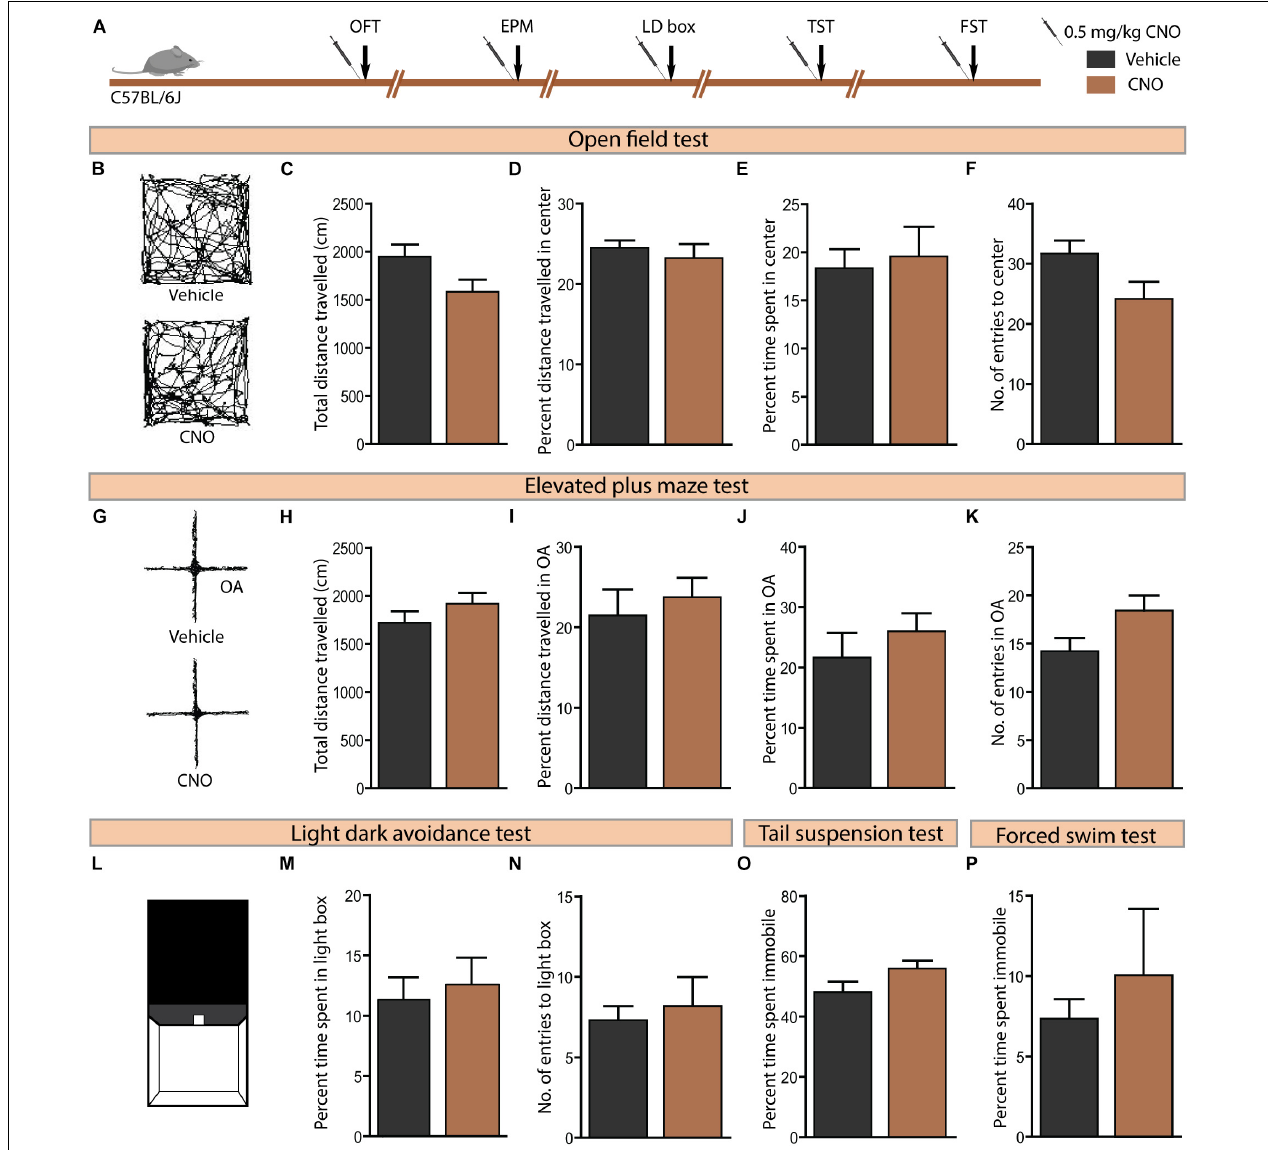
FIGURE 6 | Acute CNO administration in C57BL/6J mice does not influence anxiety or despair-like behaviour. (A) Shown is a schematic of the experimental paradigm used to determine the influence of acute CNO (0.5 mg/kg) administration in C57BL/6J mice, the background strain for the bigenic CamKII α -tTA:TetO-hM3Dq and CamKII α -tTA:TetO-hM4Di mouse lines, on anxiety and despair-like behaviours. Treatment groups were subjected to a battery of anxiety and despair-like behavioural tasks, with an interim washout period of 7–10 days ( n = 10–12/group). (B) Shown are representative tracks from a vehicle and CNO treated C57BL/6J mouse in the OFT (B–F) . CNO administration to C57BL/6J mice did not influence anxiety-like behaviour in the OFT as indicated by no change observed in the total distance travelled (C) , percent distance travelled in the centre (D) , percent time spent in the centre (E) , and number of entries made to the centre (F) as compared to vehicle-treated controls. (G) Shown are representative tracks from a vehicle and CNO treated C57BL/6J mouse in the EPM test (G–K) . CNO administration to C57BL/6J mice did not influence the total distance travelled (H) , percent distance travelled in the open arms (OA) (I) , percent time spent in the open arms (J) , and number of entries to the open arms (K) of the EPM. (L) Shown is an illustration of the chamber used in the light–dark (LD) avoidance test (L–N) . CNO administration to C57BL/6J mice did not influence percent time spent in the light chamber (M) and number of entries made to the light chamber (N) . CNO administration to C57BL/6J mice did not influence despair-like behaviour in the TST and FST, with no change noted in percent time spent immobile in both the TST (O) and the FST (P) , as compared to vehicle-treated CamKII α -tTA:TetO-hM4Di mice. Results are expressed as the mean ± SEM ( n = 10–12/group), two-tailed, unpaired Student’s t